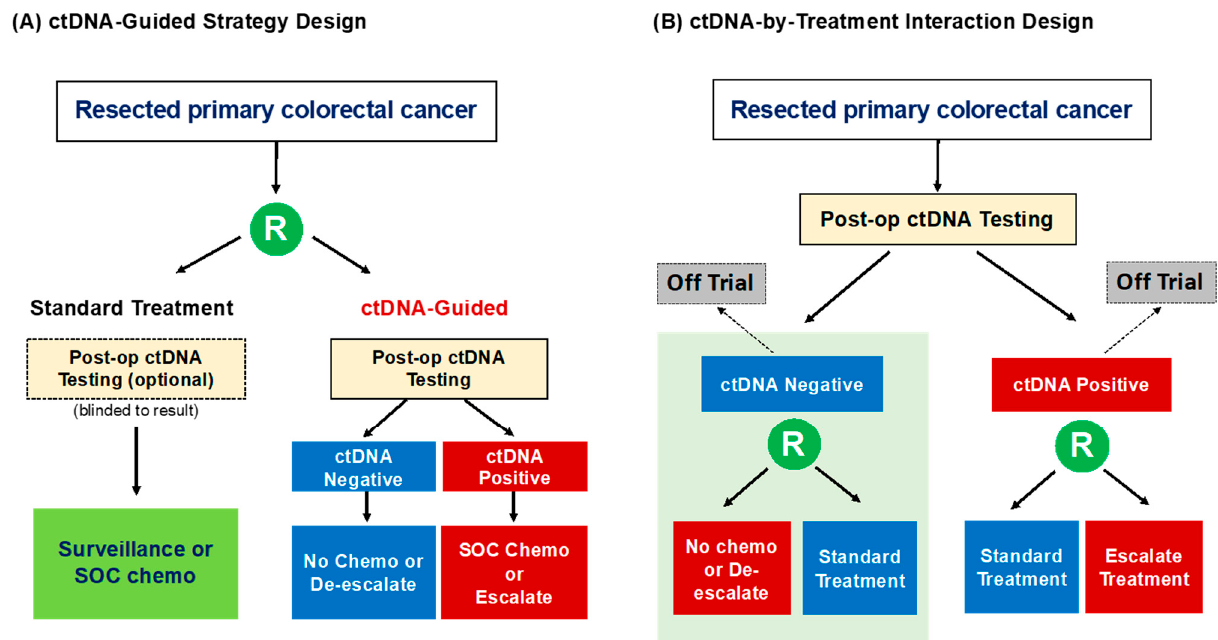
Figure 1. ctDNA-based randomised trial designs to demonstrate the clinical utility of ctDNA testing in the adjuvant set- ting.